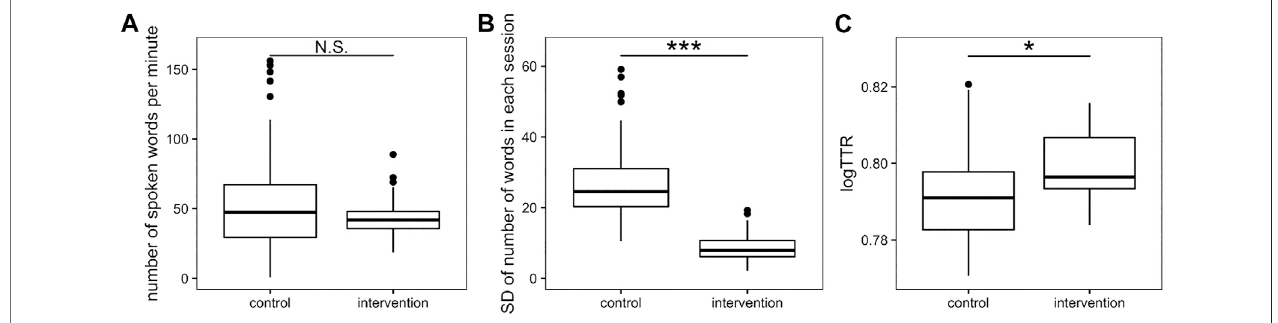
FIGURE 5 | Boxplots for results of conversational analysis. (A) The number of spoken words per minute, (B) standard deviation (SD) of number of words, and (C) logTTR. * p < 0.05, *** p < 0.001.